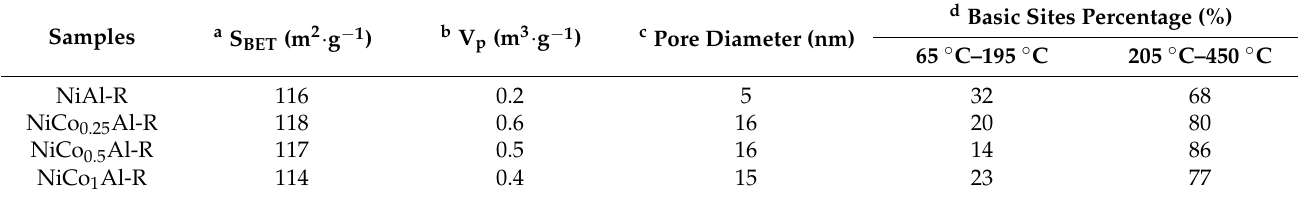
Figure 5. CO 2 -TPD patterns of NiCo x Al-R catalysts. Table 1. Physical and chemical properties of NiCo x Al-R samples.